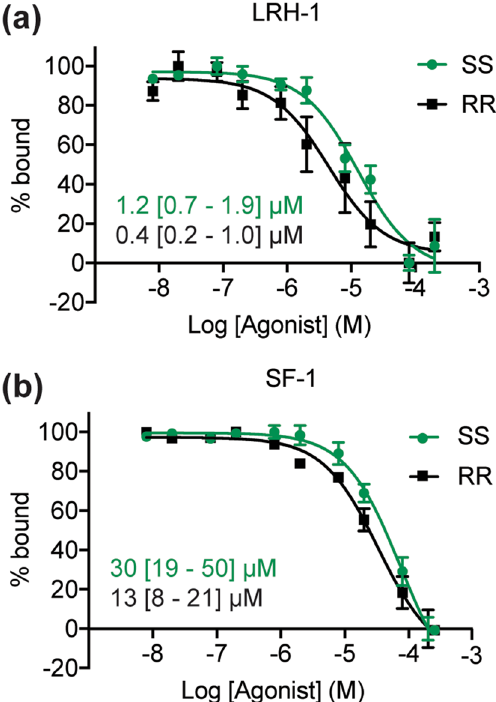
Figure 2. Binding affinities of RJW100 enantiomers. ( a , b ) Normalized FP dose–response curves from competition binding experiments using purified ( a ) LRH-1 or ( b ) SF-1 LDB showing that the ligands displace the probe. Each point represents the mean ± SEM of two independent experiments conducted in quadruplicate. Insets indicate the mean K i values calculated from these curves (95% confidence intervals are in square